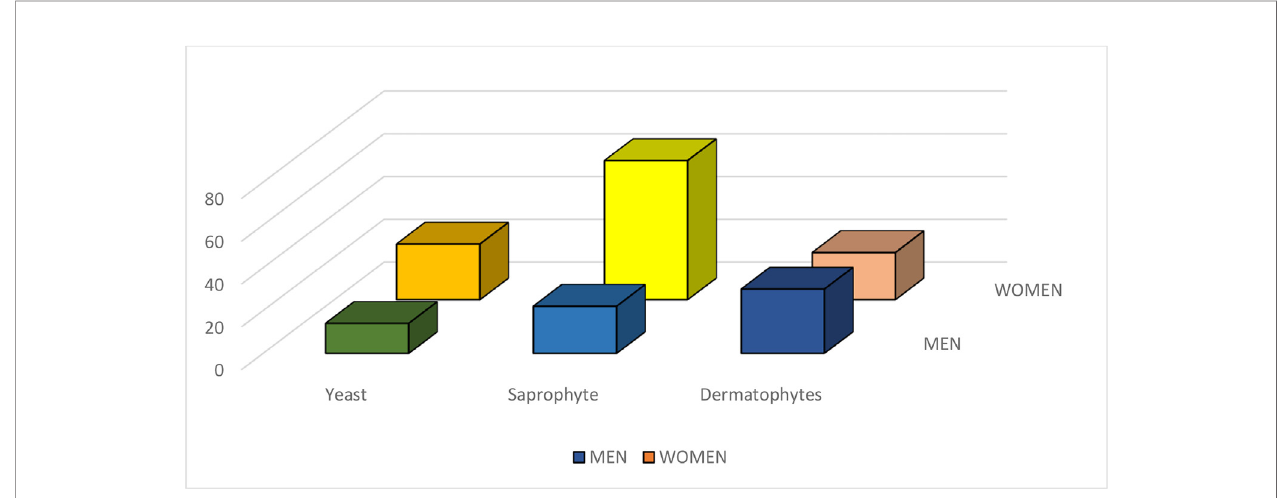
FIGURE 1 | The frequency of causative agents of onychomycosis in regard to patient ’ s gender.